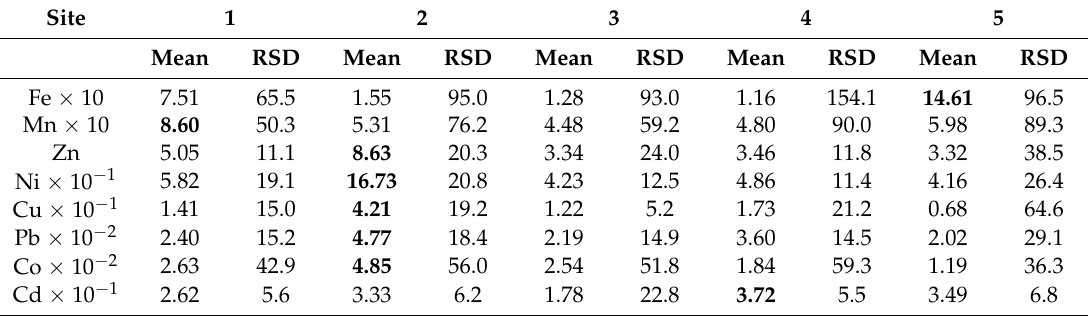
Table 3. Mean F DGT (pg · cm − 2 · s − 1 ) and RSD (%) of eight metals in vertical profiles at five sites in Lake Taihu a